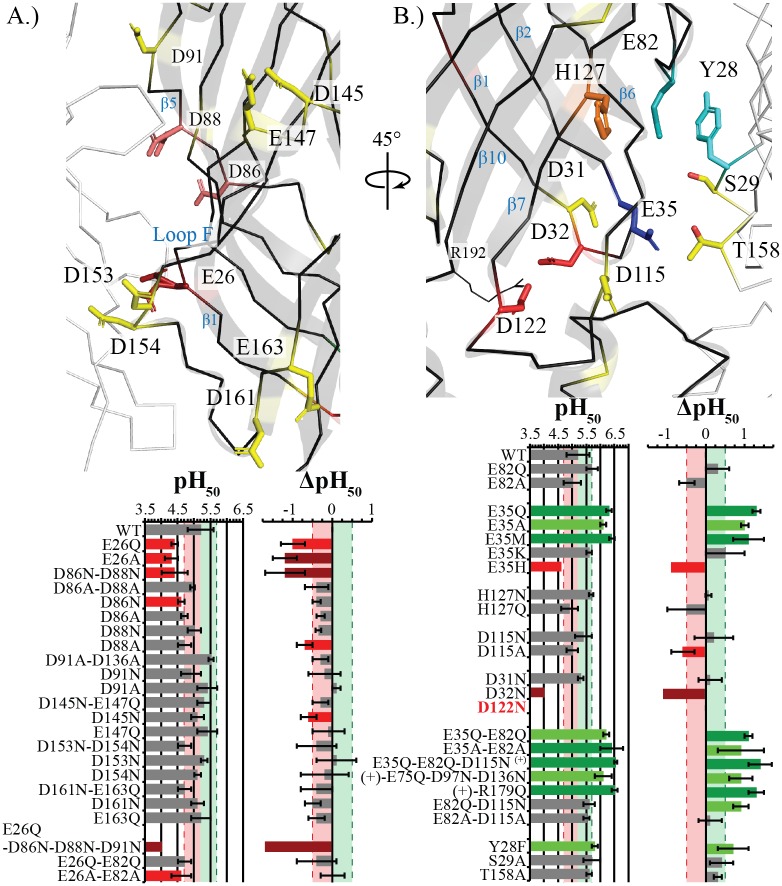
Basal ECD mutations have the greatest influence on activation.Stick representation of the evaluated Asp, Glu, and His residues are labeled and color coded based upon effect, with residues in red producing significant decrease in pH50 as a single mutation, in pink a significant decrease in combination, in yellow an insignificant or weak effect, and in blue a significant increase in pH50. The main subunit is shown in black with ribbon and cartoon representation, whereas the neighboring subunits are represented in white ribbon. Tables of the pH50 and ΔpH50 values are shown below with mean values ± standard deviation for evaluated mutants with recorded values noted in S1 Table. Light red and green zones with dashed lines represent the respective ½ log decrease and increase from Wt. Values outside this region are color coded similarly with darker bars representing stronger shifts. Mutants with too few replicates as a result of diminished maximal currents to discern an accurate pH50 have the error bars removed. (A) Complementary inter-subunit residues. Almost all mutated residues decrease with respect to Wt, with only E26 having a significant loss of function shift. D86 and D88, colored in pink, produce a significant decrease in combination. (B) Principal and ECD-TMD interface residues. The mutation of H127, shown in orange, has no effect, whereas E82 is shown in teal to identify the residue. Hydroxyl-containing residues on the complementary subunit that were evaluated are also shown with the only significant residue, Y28, shown in cyan. D122N is bolded and in red as it was nonfunctional. ECD, extracellular domain; TMD, transmembrane domain; Wt, wild-type.